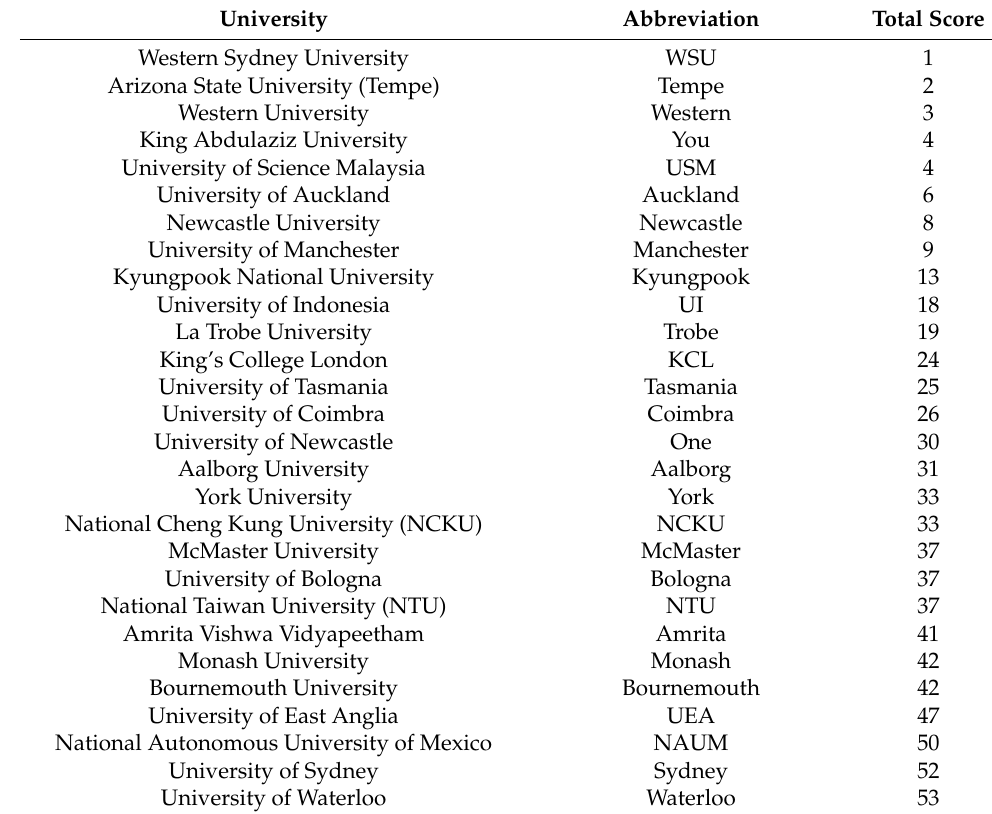
Table 4. Universities analyzed, abbreviations, and total